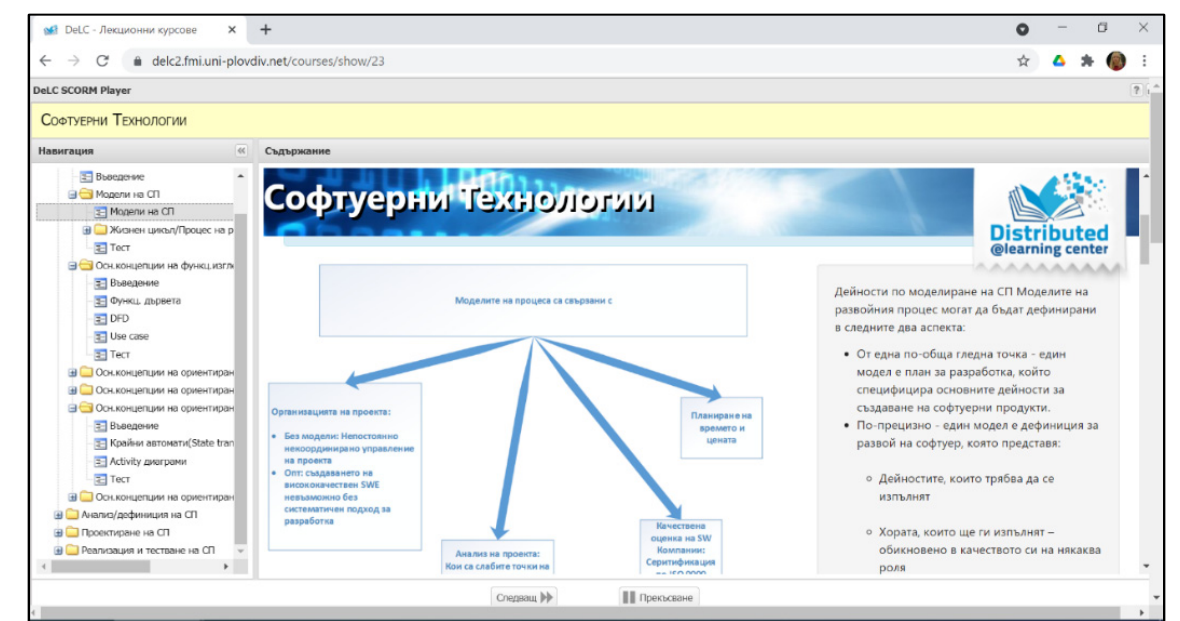
Figure 2. SCORM Player in DeLC 2.0 (in Bulgarian).